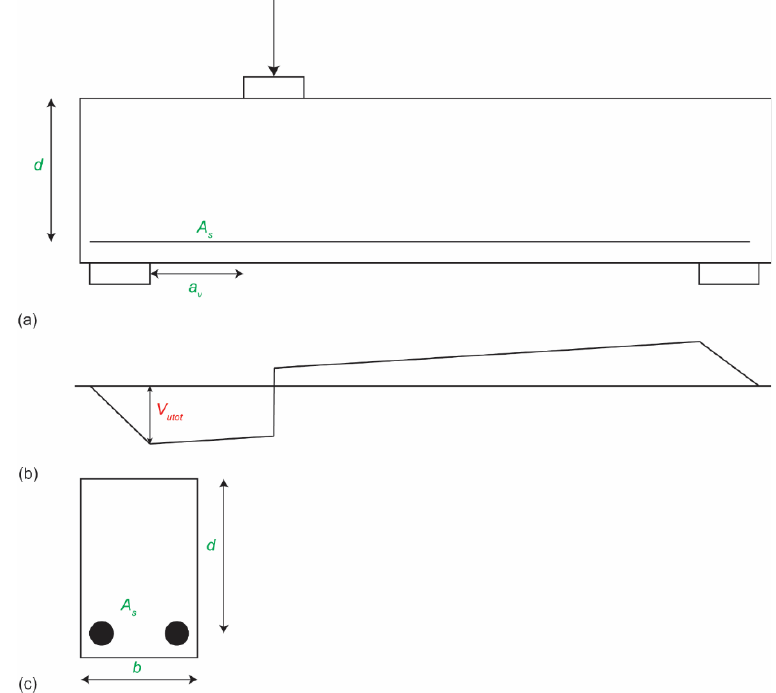
Figure 2. Input and output variables: ( a ) test specimen, side view; ( b ) resulting sectional shear diagram, showing maximum value V utot ; ( c ) cross-section of specimen. Table 2. Overview of input and output variables considered in the dataset, including ranges of values.